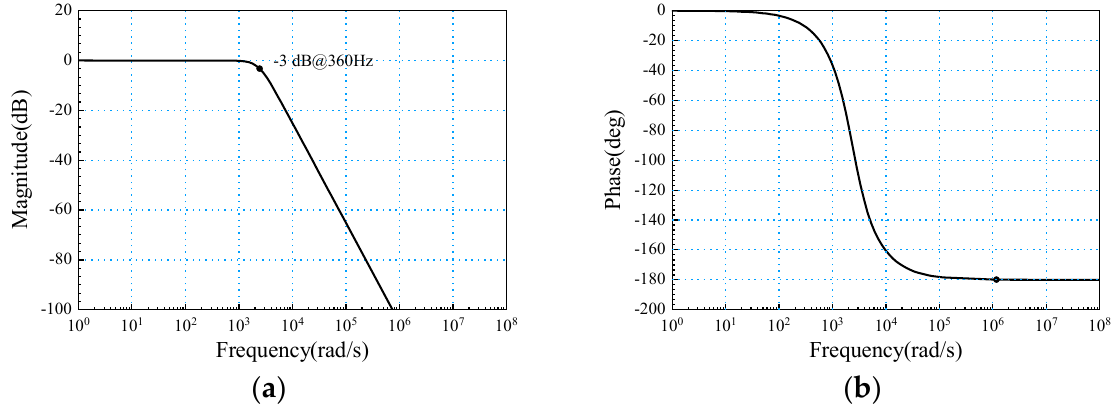
Figure 8. System current loop frequency characteristic curve. ( a ) Amplitude diagram. ( b ) The phase diagram.